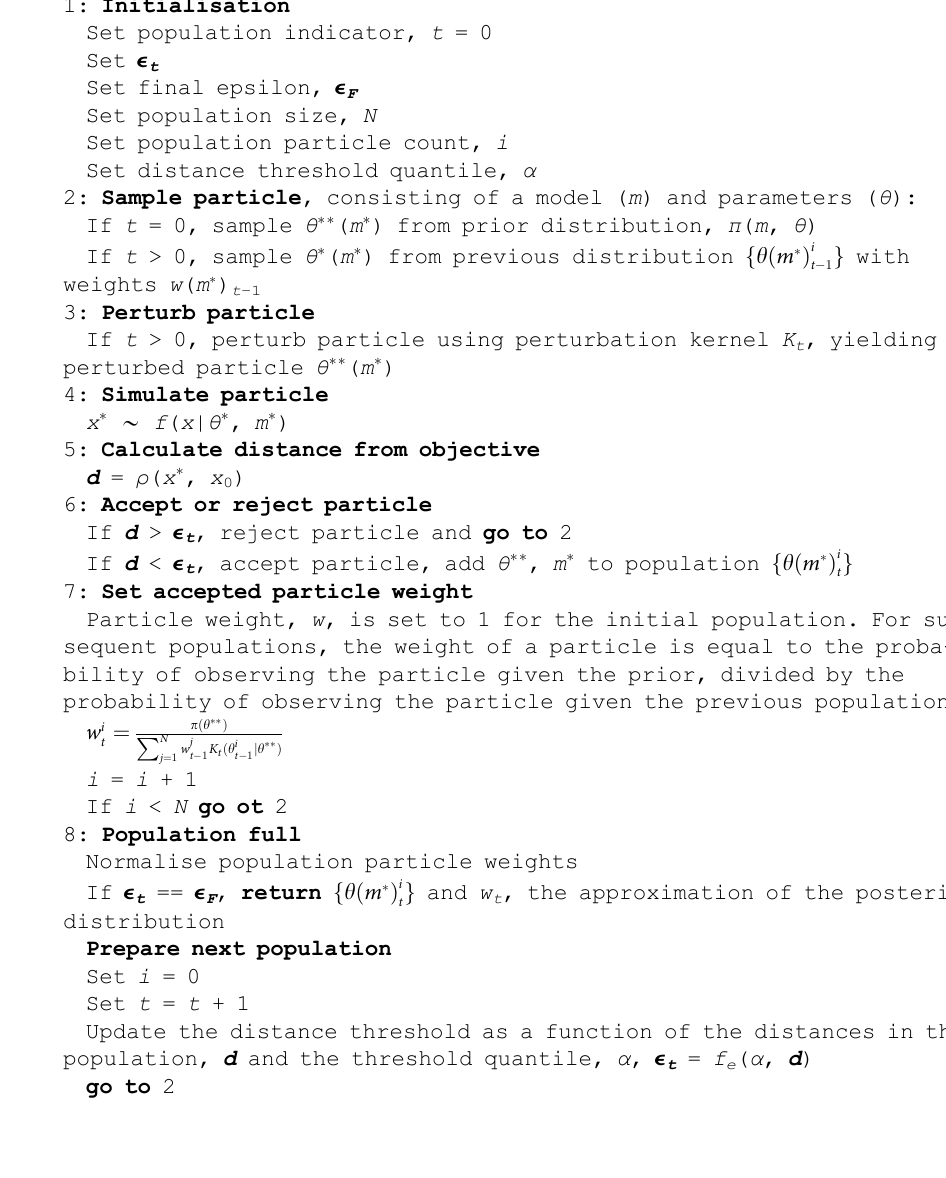
Algorithm 1: Algorithm for model selection with ABC